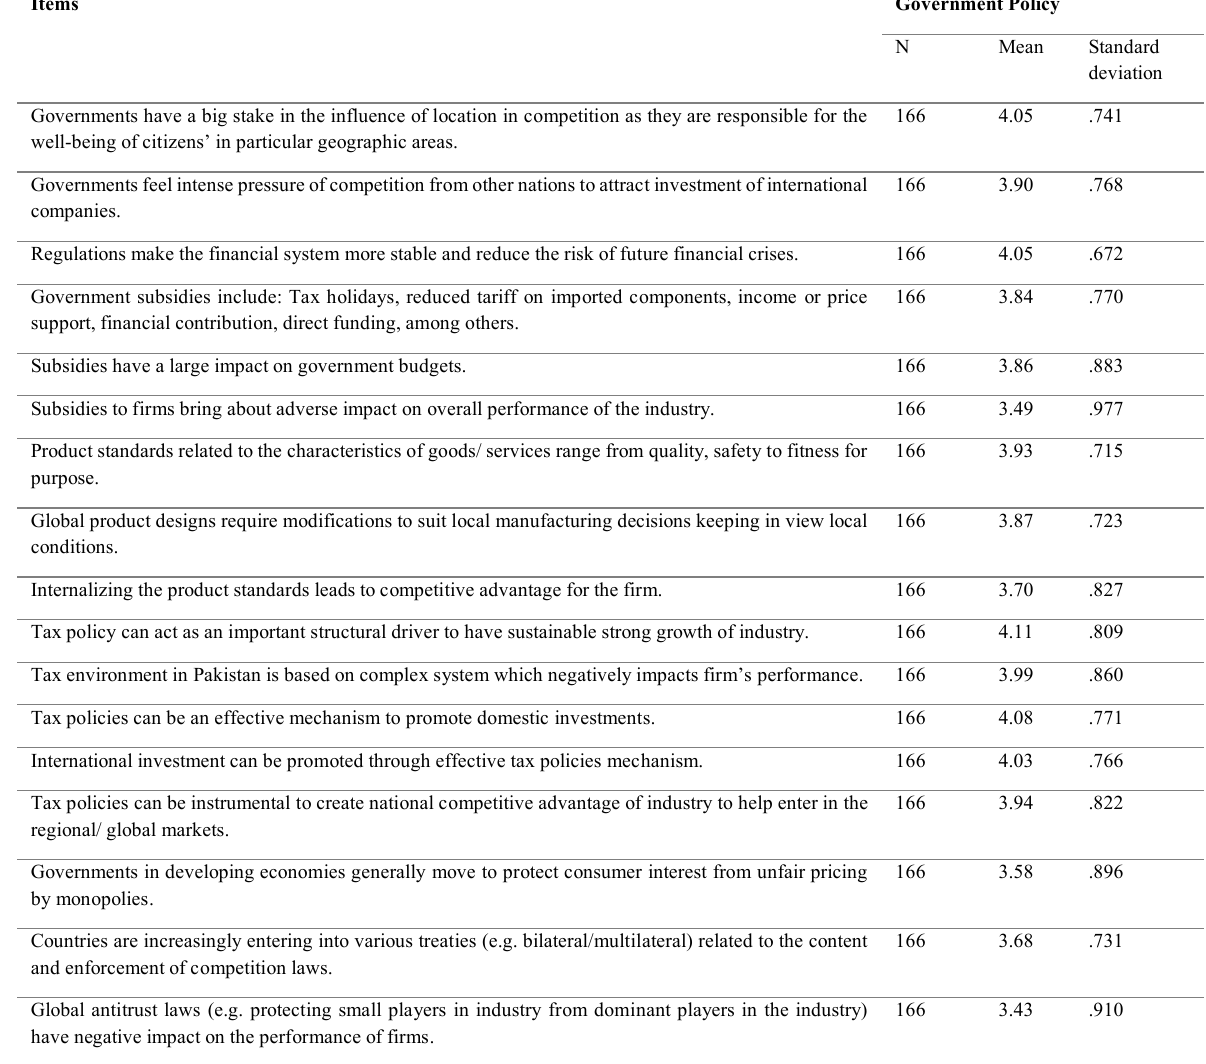
Table 2 : Mean and standard deviation for government policy